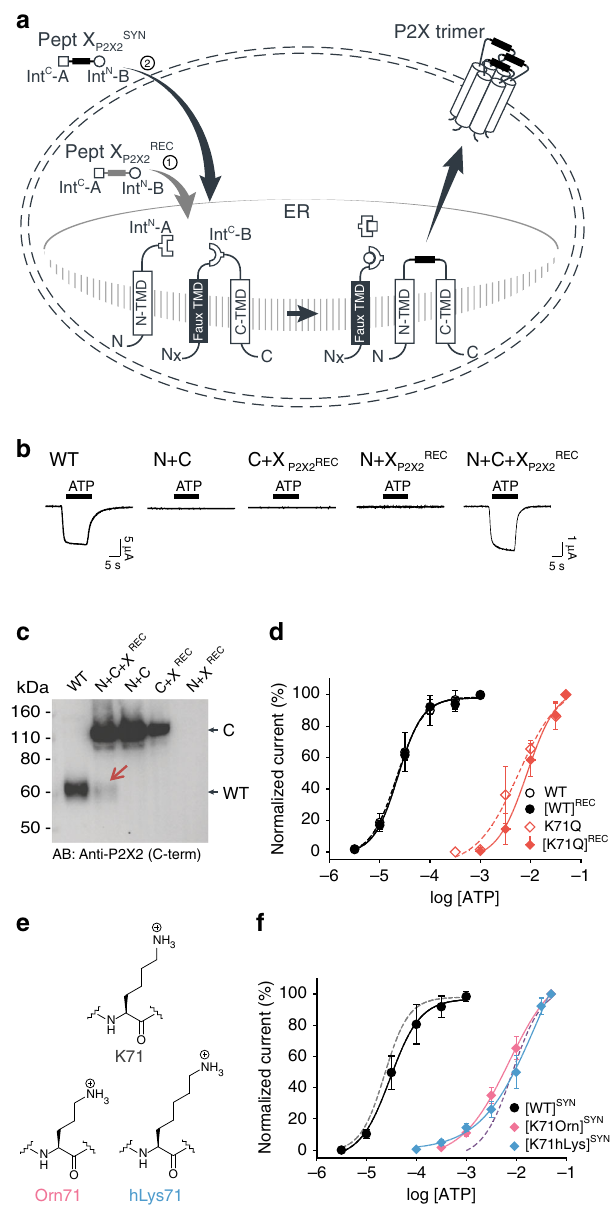
Fig. 6 Insertion of recombinant and synthetic peptides into the P2X2R extracellular domain. a Schematic presentation of the strategy to reconstruct full-length P2X2Rs from recombinantly expressed N-/C- terminal fragments (N and C) and a recombinant (strategy 1, Pept